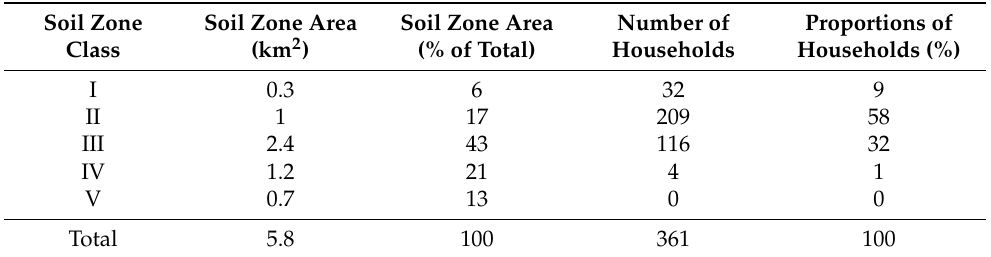
Table 5. Soil zones and residential distributions for BRASS transects [adapted from [23] Table 3]. (Compare with Table 3